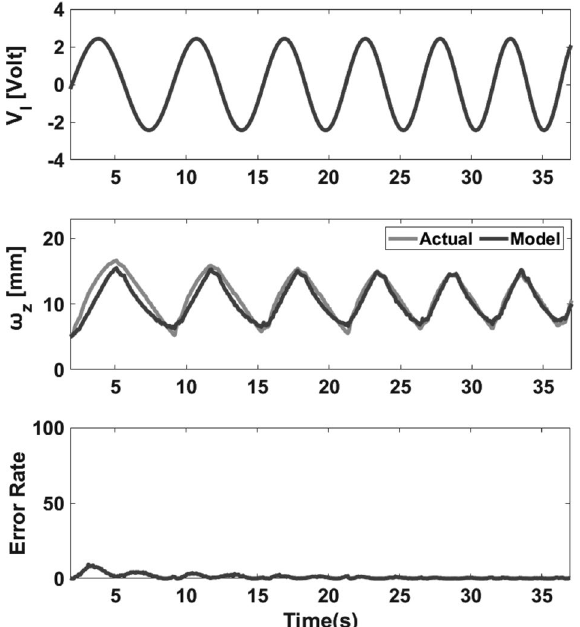
Figure 6. Model validation. Top: applied chirp voltage (with increasing frequency (up-Chirp)) to the IPMC (with a peak voltage of 2.3 V). Middle: the actual and estimated tip displacement of the IPMC in the x- direction. Bottom: the square error rate.